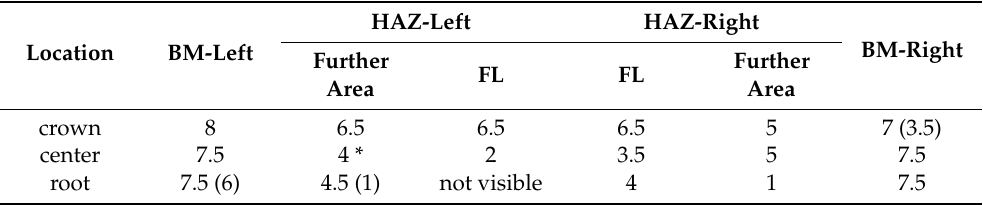
Table 7. Grain size G in the A sample, aged at 650 ◦ C for 15,000 h.